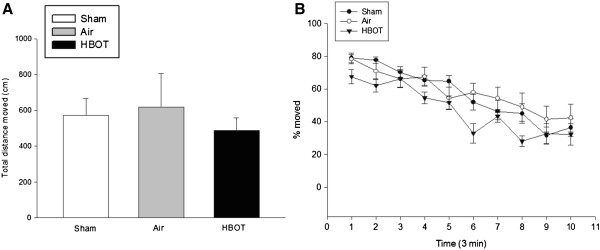
Effects of HBOT on open field test. There was no difference between air and HBOT group in the total distance moved (cm) (Figure 3A) and total duration of moving (%) (Figure 3B). The animal number was 20, 20 and 22, respectively in the sham, air and HBOT group.